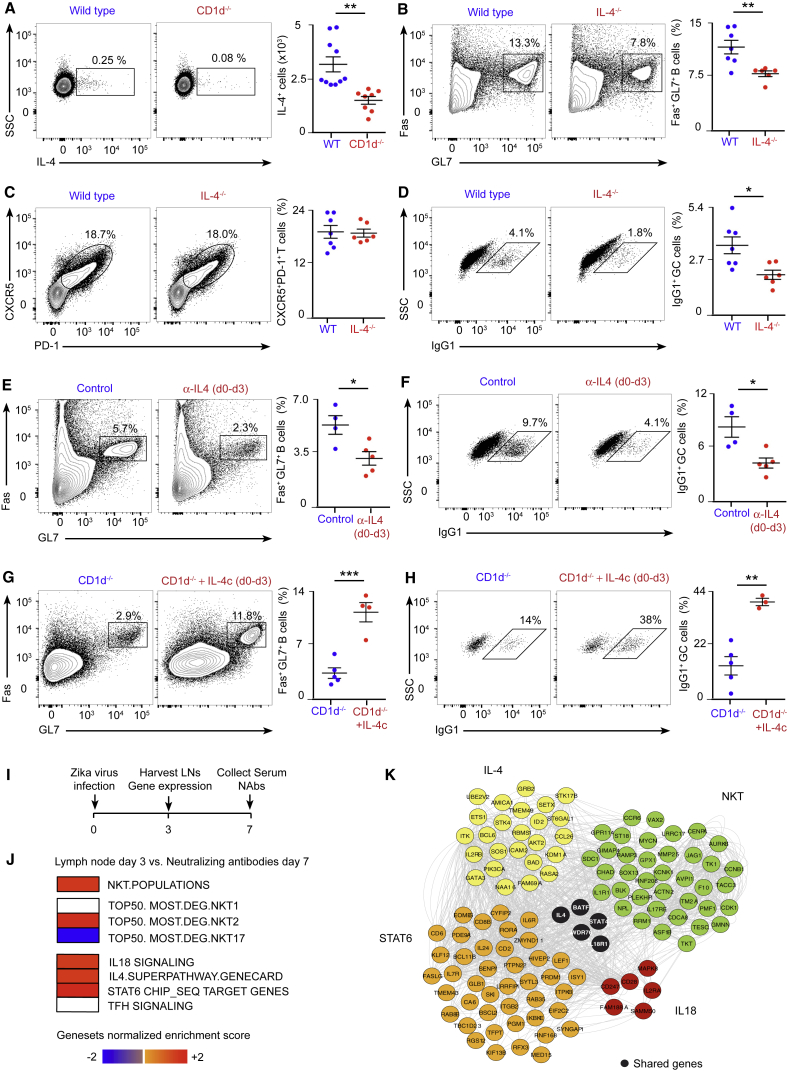
A Conserved Early IL-4 Wave Is Critical for Induction of B Cell Immunity(A) Flow cytometry analysis on day 3 of influenza infection. Graphs show the number of IL-4+ lymph node cells in wild-type (blue dots) and CD1d−/− (red dots) animals.(B–D) Flow cytometry analysis on day 8 of influenza infection. Graphs show the percentage of (B) germinal center, (C) TfH, and (D) IgG1+ cells in wild-type (blue dots) and IL-4−/− mice (red dots).(E and F) Flow cytometry analysis on day 8 of influenza infection of wild-type mice treated with PBS or blocking α-IL-4 antibody during the initial 3 days of infection. Graphs show (E) germinal center and (F) IgG1+ cells in wild-type (blue dots) and α-IL-4 treated mice (red dots).(G and H) Flow cytometry analysis on day 8 of influenza infection of CD1d−/− mice treated with PBS or IL-4 complex (IL-4c) during the initial 3 days of infection. Graphs show (G) germinal center cells and (H) IgG1+ cells in wild-type (blue dots) and IL-4c-treated mice (red dots).(I) Experimental scheme showing the Zika virus infection strategy.(J) Linear regression model of gene signatures for NKT cells, TfH cells, IL-4, STAT6, and IL-18 from harvested lymph nodes on day 3 with neutralizing antibodies measured in plasma on day 7. Red squares, positive correlation; blue squares, negative correlation; white squares, no significant correlation.(K) Gene-interacting network inference representing interconnectivity of NKT cells, IL-4, STAT6, and IL-18 pathways.In (A)–(H), each dot represents a single mouse. Data are representative of three independent experiments. Statistical analysis: two-tailed Student’s t test, ∗p < 0.05, ∗∗p < 0.01, ∗∗∗p < 0.001.